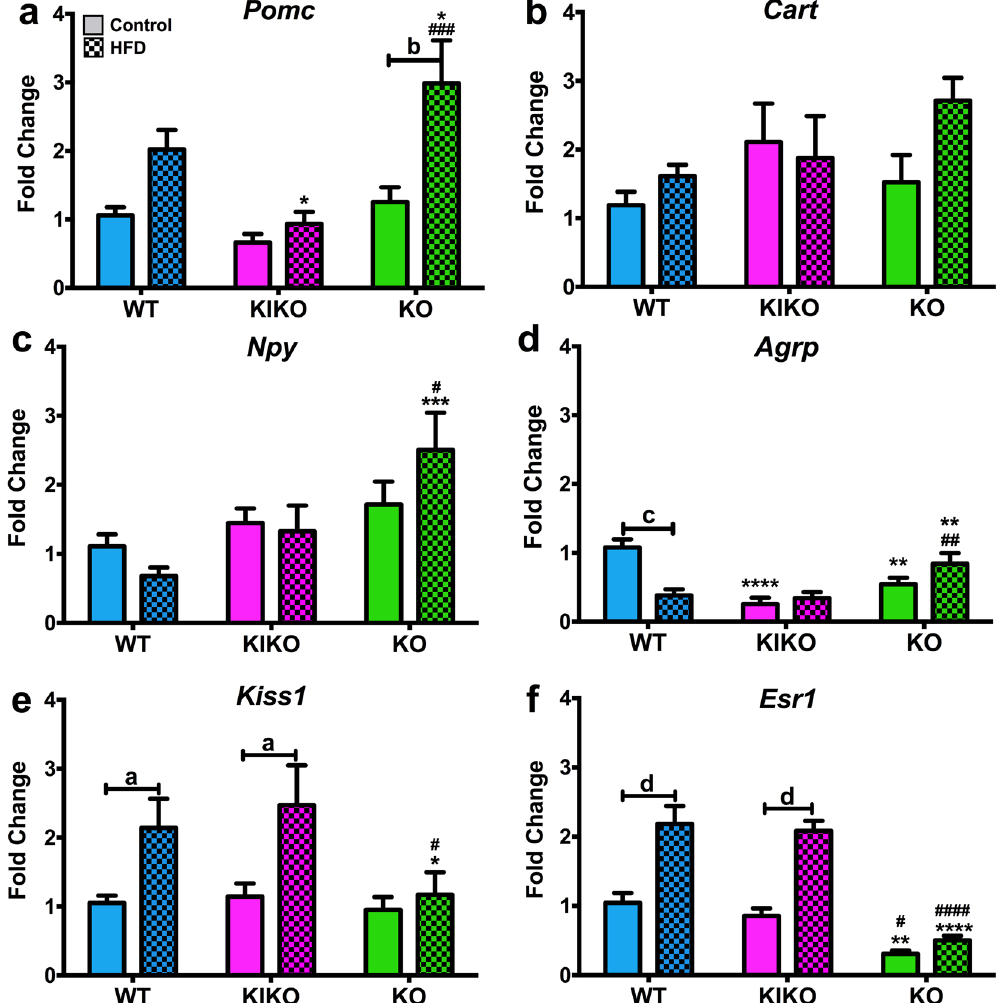
Figure 6. Arcuate gene expression in all genotypes after 20 weeks of adult chow diet. ( a ) Pomc ; ( b ) Cart ; ( c ) Npy ; ( d ) Agrp ; ( e ) Kiss1 ; and ( f ) Esr1 (ER α ) expression normalized to WT from Control-fed dams. Data were analyzed by a two-way ANOVA with post-hoc Newman-Keuls test within each genotype. See Fig. 1 for information on treatment categories, sample sizes, and statistical comparisons ( a/ * /# = P < 0.05; b/ ** /## = P < 0.01; c/ *** /### = P < 0.001; d/ **** /#### = P <